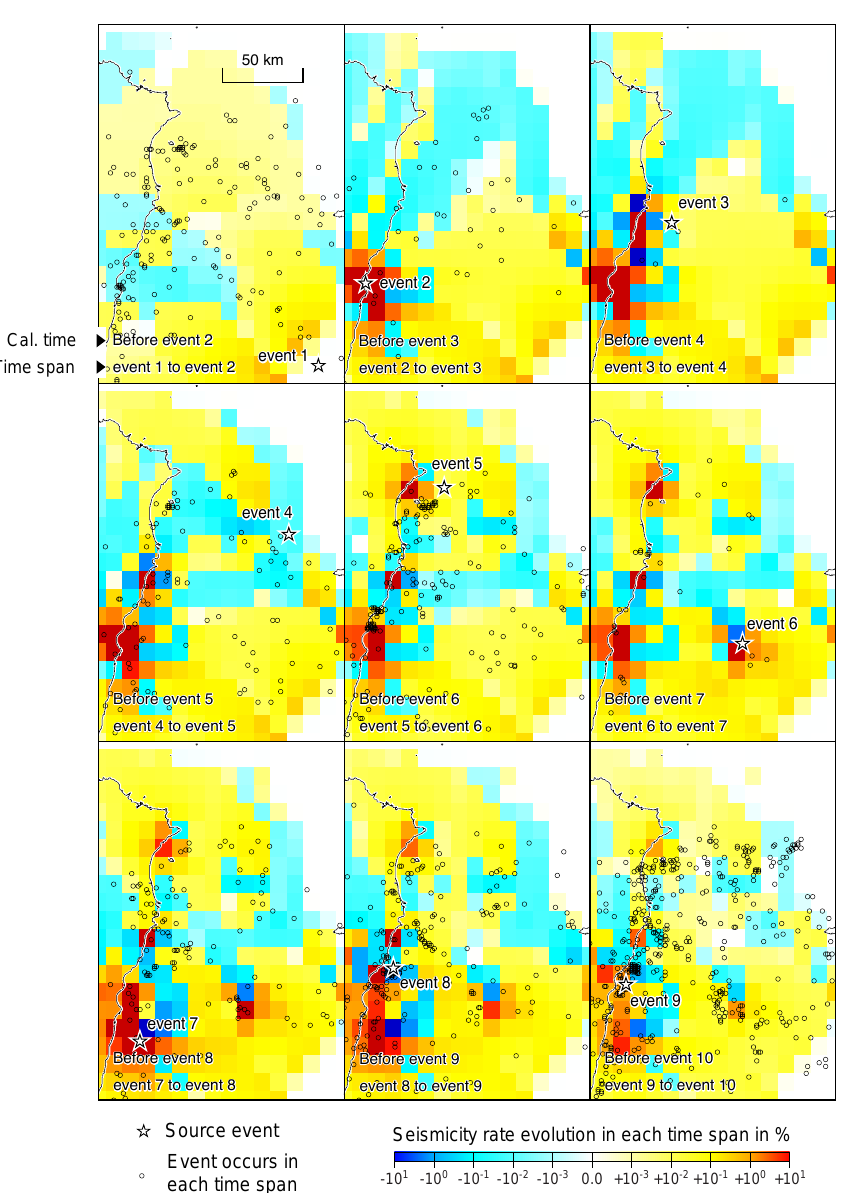
Figure 3. The seismicity rate evolution at different time moments. The target depth for the (cid:49) CFS calculation corresponds to the hypocentral depth of each source event (Table 1). Source events from 2010 to 2011 are shown as open black stars. Open circles denote earthquakes during each time